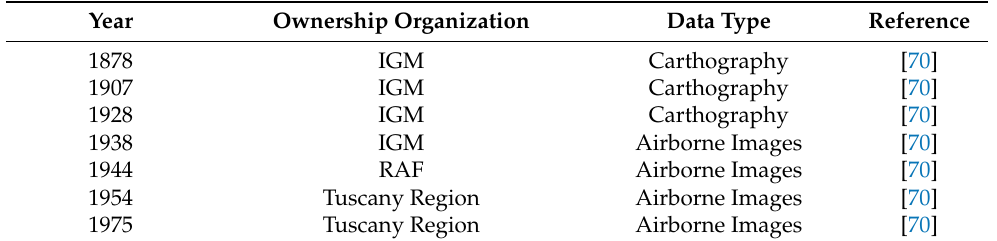
Table 1. Details about coastline data showing the year of acquisition, the ownership, some additional data, and the